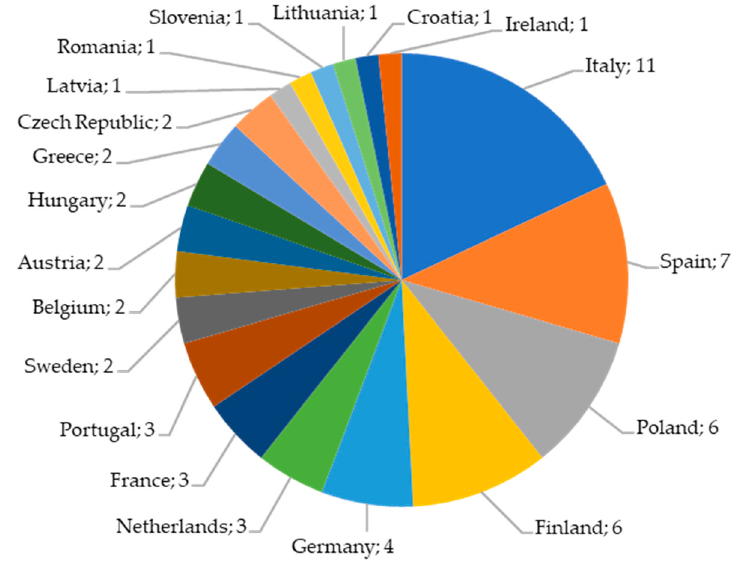
Figure 2. Number of sustainability reports included in the research sample (by country).